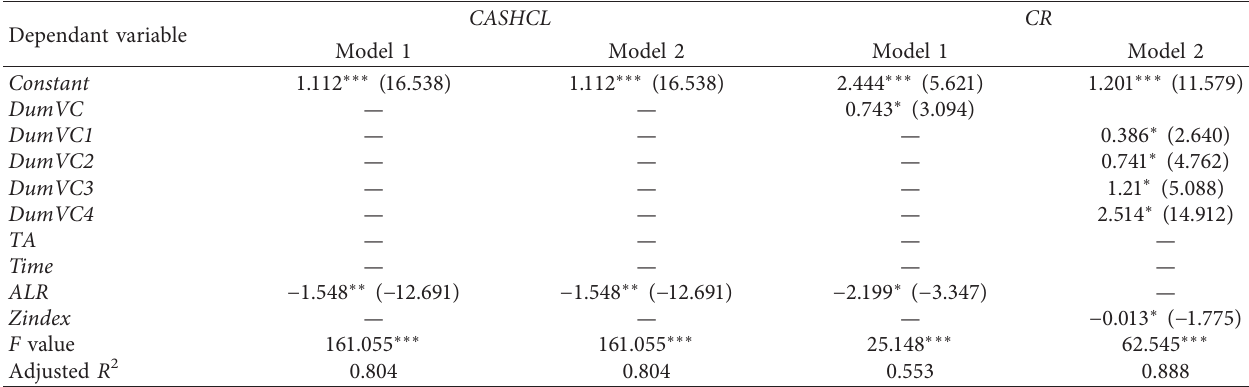
Table 5: Effect of venture capital on the solvency of SMEs.